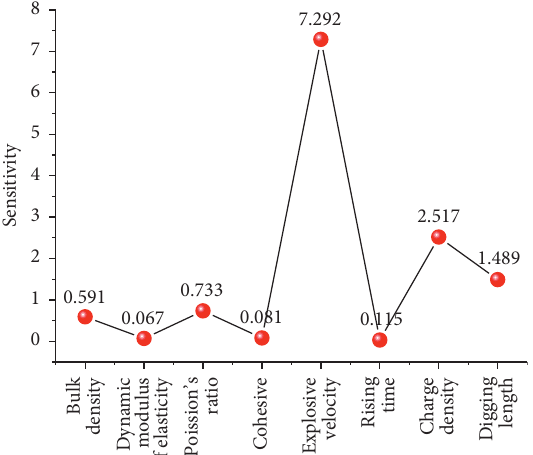
Figure 23: Changes of PPV of right wall with different charge density time versus time.